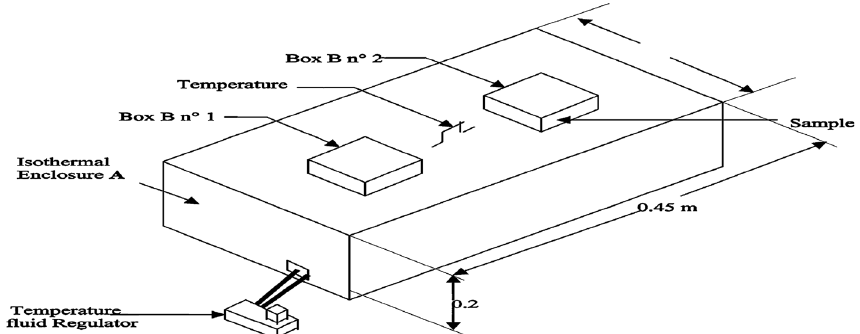
Fig. 1 Experimental setup of the boxes